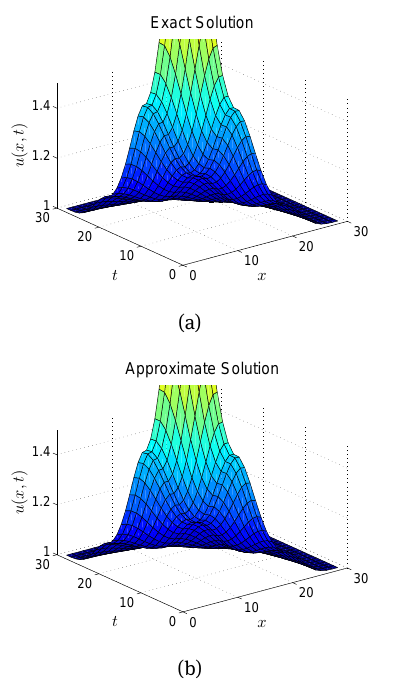
Figure 10: Space-time graph of the exact solution and approximate solution for example